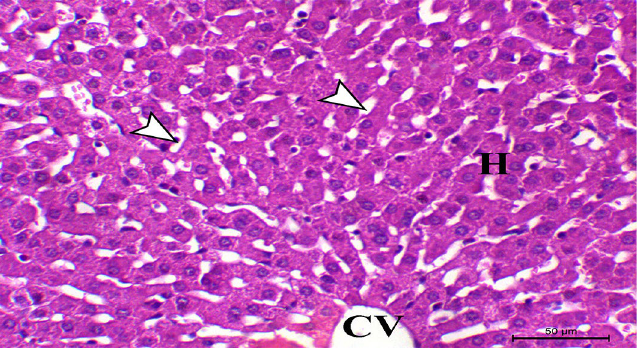
Figure 1. Photomicrograph of the hepatic section of control rabbit, showing normal hepatic cells (H letters) arranged in cords and searated with sinusoids (arrowheads) around the central vein (CV), (H&E stain), X200, bar = 50 µm.